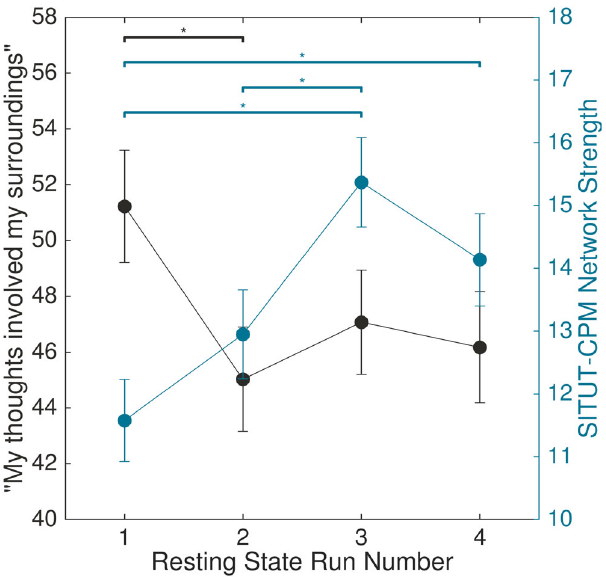
Fig. 7 Across rs-fMRI scans, thoughts about surroundings decrease while SITUT-CPM network strength increases over time. In the University of Leipzig dataset, experience sampling following each ~15 min rs-fMRI run (within one session) revealed that self-reported thoughts involving surroundings decreased (i.e., stimulus-independence of thoughts increased) after the fi rst run and then remained relative stable (black; participants included in analyses: n = 164 for run 1; n = 164 for run 2; n = 164 for run 3; n = 162 for run 4). Conversely, SITUT-CPM strength increased after the fi rst run (blue; participants included in analyses: n = 140 for run 1; n = 165 for run 2; n = 140 for run 3; n = 146 for run 4). Solid dots indicate mean, and error bars indicate standard error of the mean. Statistical tests were corrected for multiple comparisons (* P FDR < 0.05, two-sided, Wilcoxon rank-sum test). Signi fi cant increases were found for run 3 compared to 1, 3 compared to 2, and 4 compared to 1 ( P FDR = 0.0027, 0.0039, and 0.035, respectively). SITUT stimulus-independent, task- unrelated thought, CPM connectome-based predictive model. Source data are provided as a Source data fi